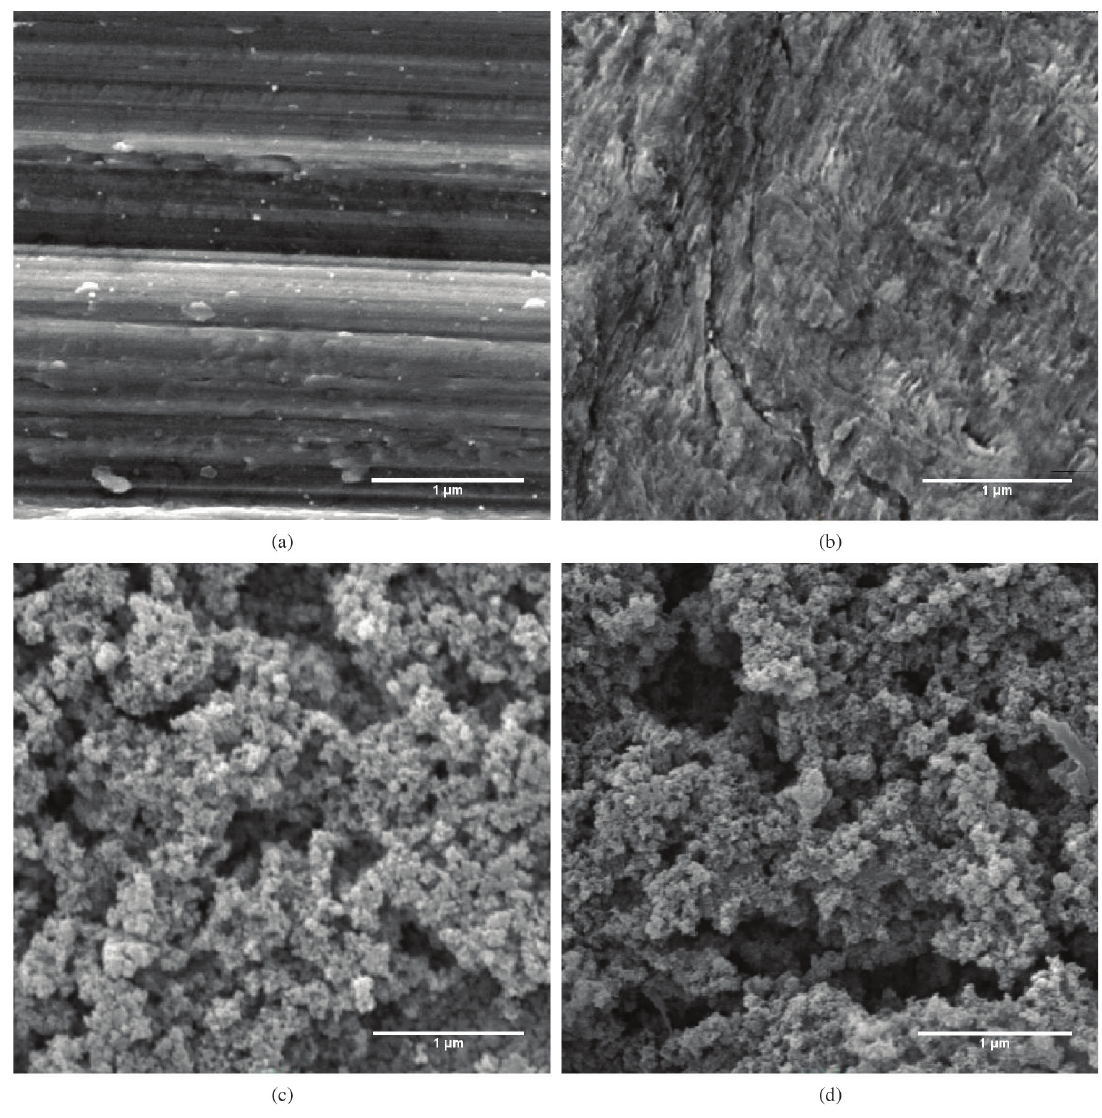
Figure 1. Surface morphology: (a) machined control; (b) acid etching and heat treatment; (c) acid etching and soaking in SBF for 7 days; (d) acid etching and soaking in SBF for 14